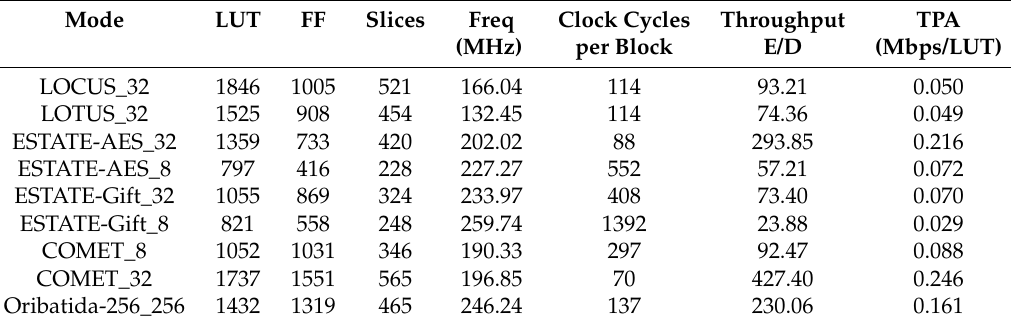
Table 2. Utilization of resources, throughput and TPA for implemented architectures on the xc7a12tcsg325- 3